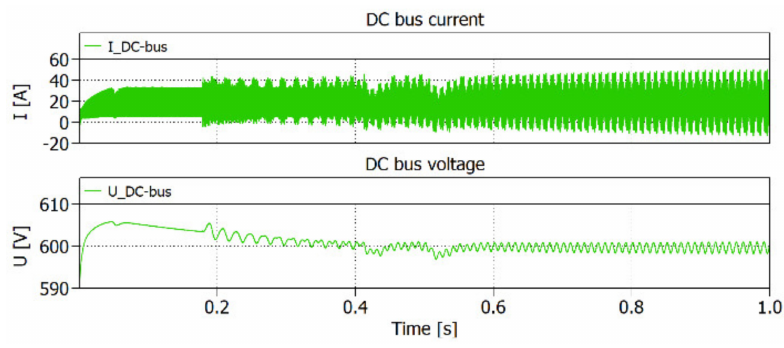
Figure 20. Current and voltage of DC bus for Scenario 1.